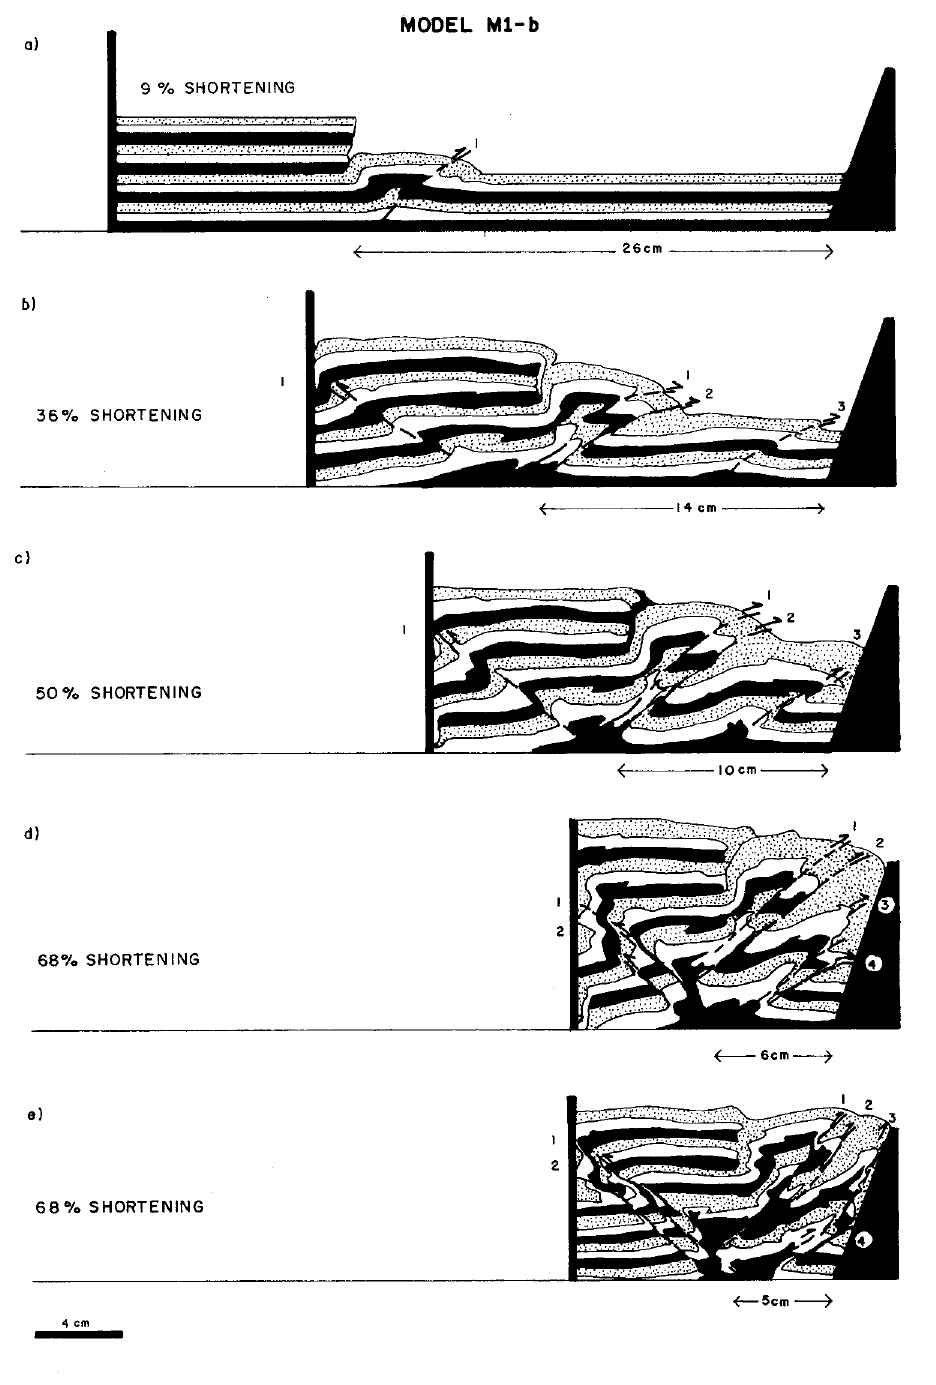
Fig. 8 – Sequential development of model M1-b (high obstacle and deformable backstop). The model illustrates the effect of a deformable backstop on the antiformal stack evolution of model M1-a after, (a) 9%; (b) 36%; (c) 50%; (d) 68% shortening (sideview); and (e) after 68% shortening (section cut 5 cm from the glass wall). The difference between models M1-a and M1-b is the dip angle of the oldest thrusts (compare Figs. 8d, e and 7d, e). An. Acad. Bras. Ci. ,(2000) 72